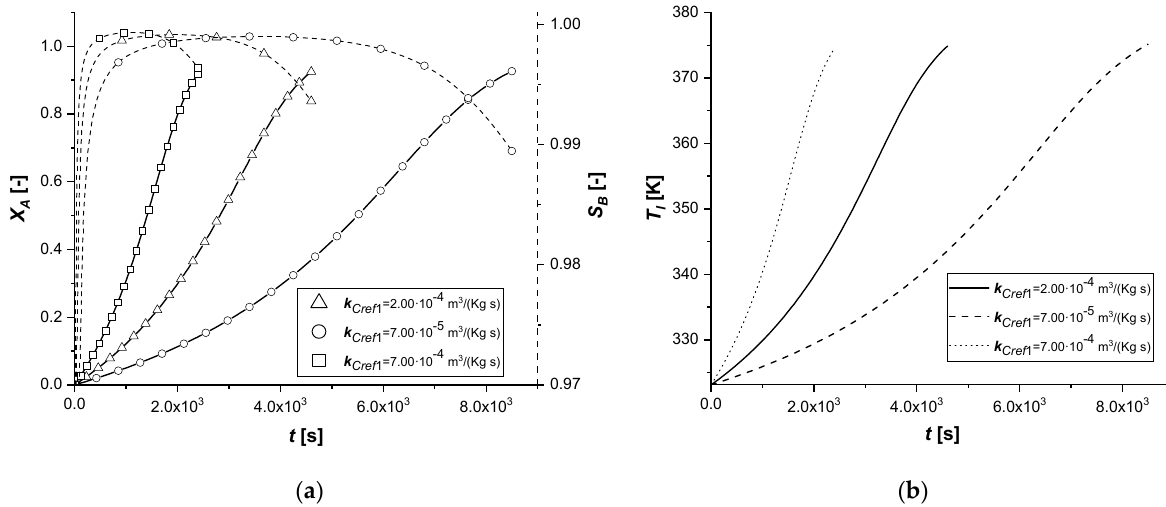
Figure 11. ES k Cref 1 investigation. ( a ) Bulk profiles over time of X A and S B . ( b ) Bulk profile of T l over time.